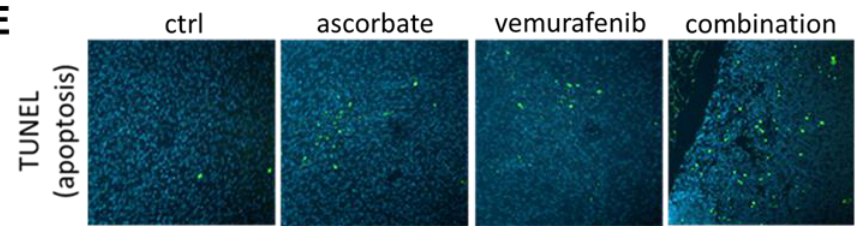
Figure 6. Treatment effects on mouse organs and weight and immunohistochemical analysis of mouse tumors. ( A ) H&E staining of mouse organs (lung, liver, gut, kidney, and spleen) of mice treated with ascorbate (3 g/kg i.p., daily), vemurafenib (30 mg/kg, five times weekly) and their combination. ( B ) Weight progress curves of mice during treatment with ascorbate (3 g/kg i.p. daily), vemurafenib (30 mg/kg i.p., five times weekly), and their combination. ( C ) H&E staining of tumors from mice treated with ascorbate (3 g/kg i.p., daily), vemurafenib (30 mg/kg i.p., five times weekly), and their combination. ( D ) Immunohistochemical staining for Pcna, Hif-1α, and Glut-1 of tumors from mice treated with ascorbate (3 g/kg i.p., daily), vemurafenib (30 mg/kg i.p., five times weekly), and their combination. ( E ) Immunofluorescent TUNEL staining of tumors from mice treated with ascorbate (3 g/kg i.p. daily), vemurafenib (30 mg/kg i.p., five times weekly), and their combination. Representative pictures are shown in a magnification of 200-fold. ns: p > 0.05.